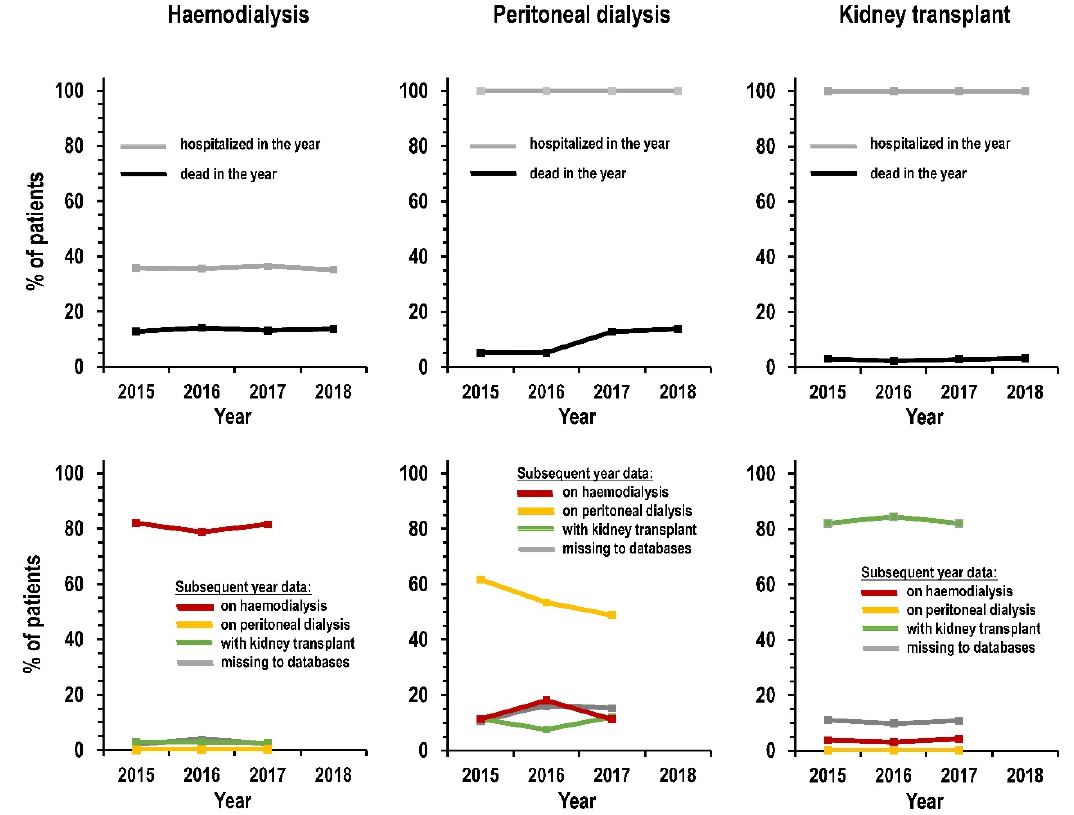
Figure 3. Prevalence (%) by type of kidney replacement treatment and by calendar year. Notes: graphs display patients with at least one hospitalization within the year (upper panels, grey line); dead within the year (upper panels, black line); on haemodialysis in the subsequent year (lower panels, red line); on peritoneal dialysis in the subsequent year (lower panels, yellow line); not on dialysis and with kidney transplant in the subsequent year (lower panels, green line); and missing from kidney replacement treatment and mortality databases of the subsequent year (lower panels, grey line).